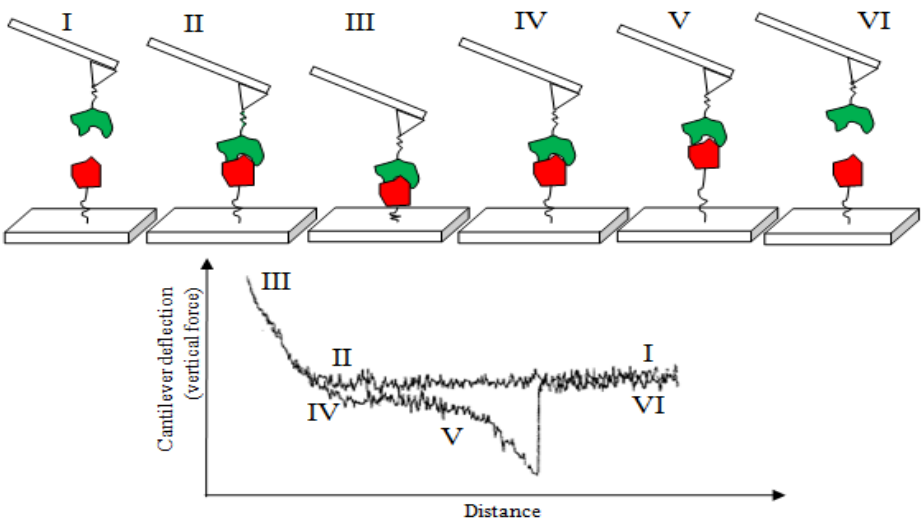
Figure 9. Schematic representation of the interaction between a functionalized AFM tip during attraction toward and retraction away from a chemically modified substrate, along with the corresponding force–distance curves; adapted with permission from [99].